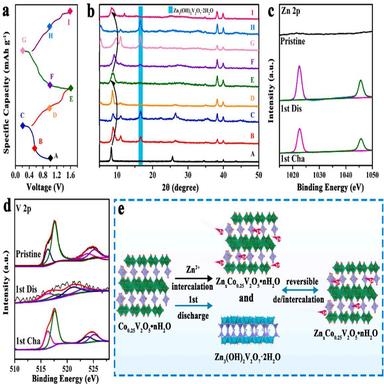
(a) Discharge/charge curves and (b) Ex-situ XRD patterns at diverse charge/discharge states, XPS spectra at different charge/discharge voltages of (c) Zn 2p and (d) V 2p, (e) schematic illustration Zn2+ intercalation into CoVO-150.